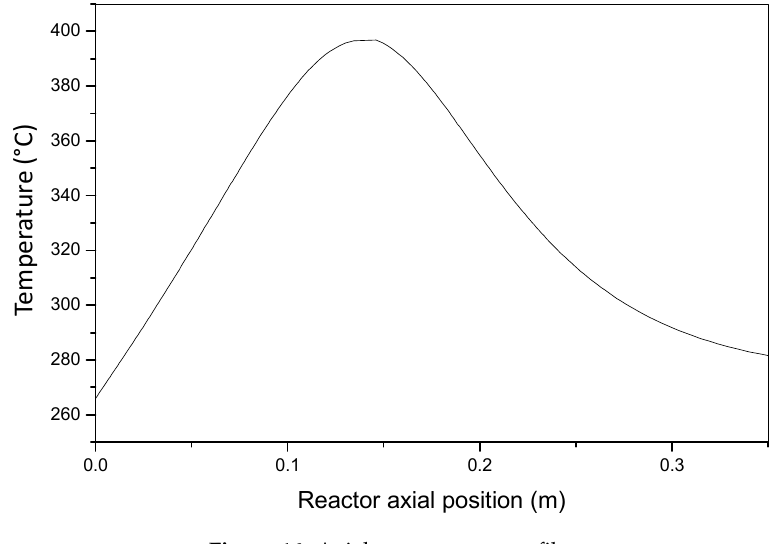
Figure 16. Axial temperature profile.